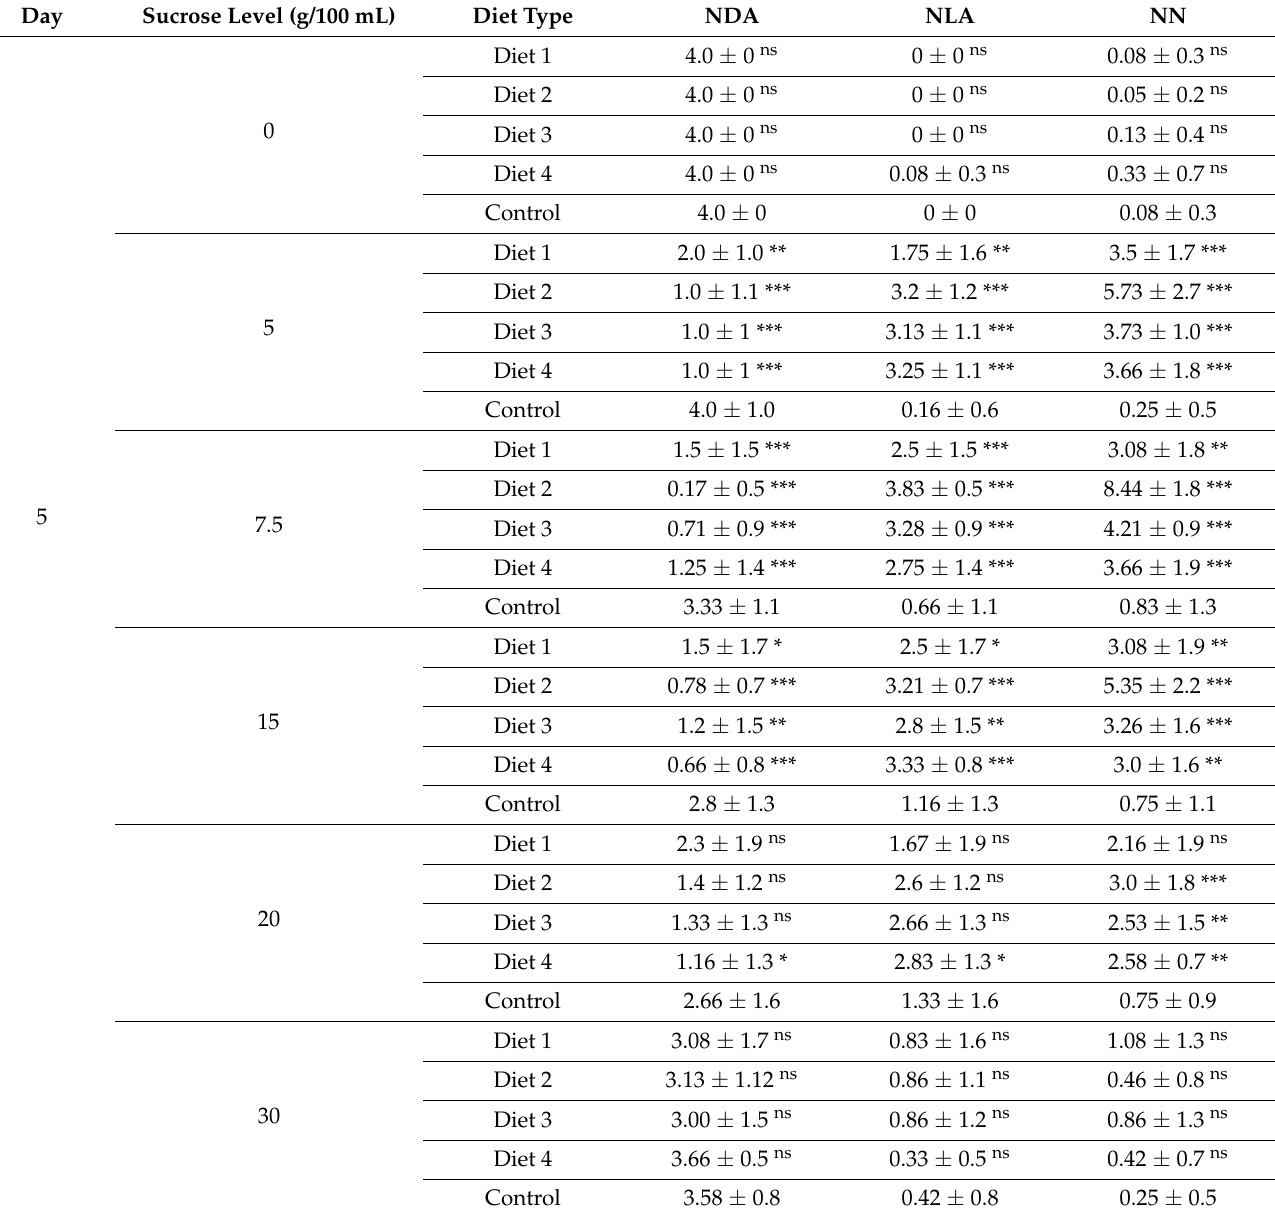
Table 1. Effect of sucrose levels and diet type on banana aphid